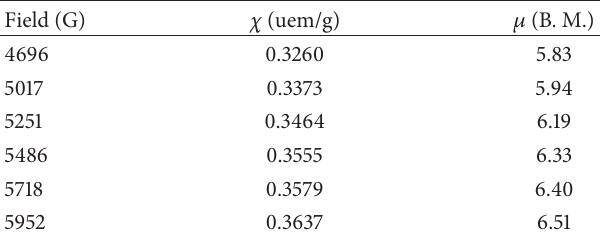
Table 1: Magnetic susceptibility and magnetic moment for 7 at different applied field strengths.